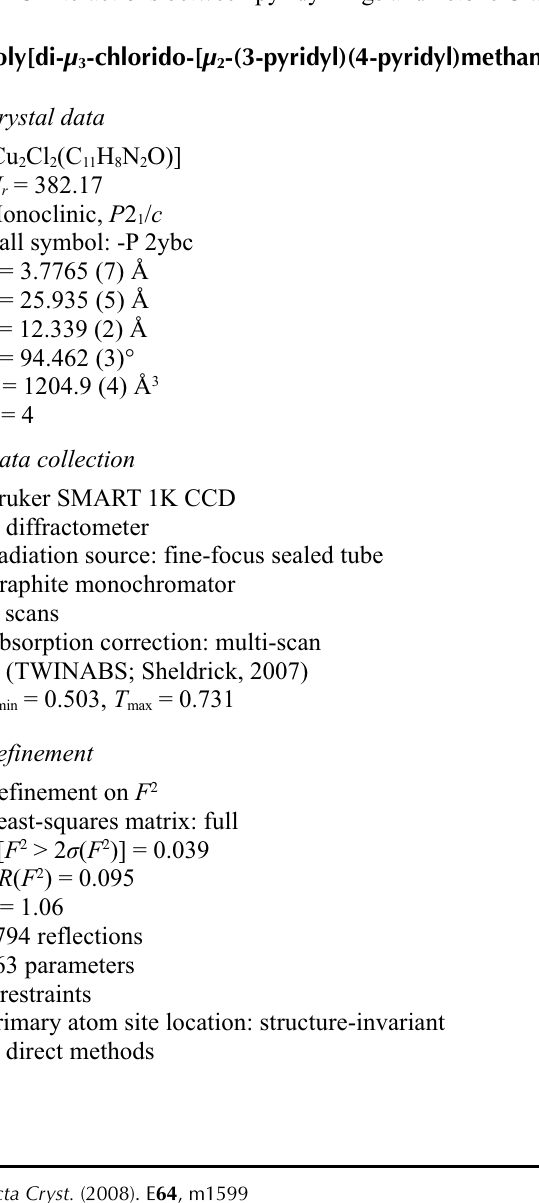
Figure 3 Packing diagram illustrating the AB layer stacking pattern, which forms the 3-D crystal structure of (I) through weak C— H···O interactions between pyridyl rings and ketone O